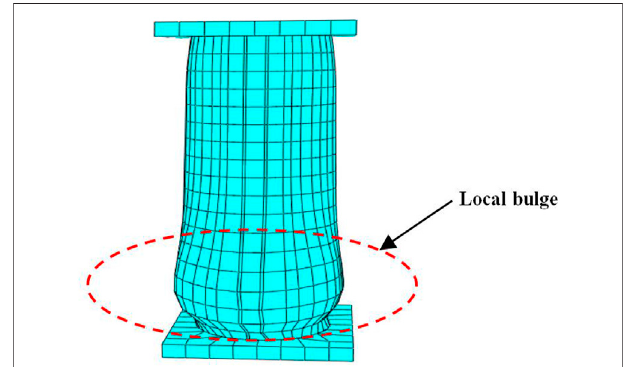
FIGURE 8 | The failure mode of specimen GRS-1.